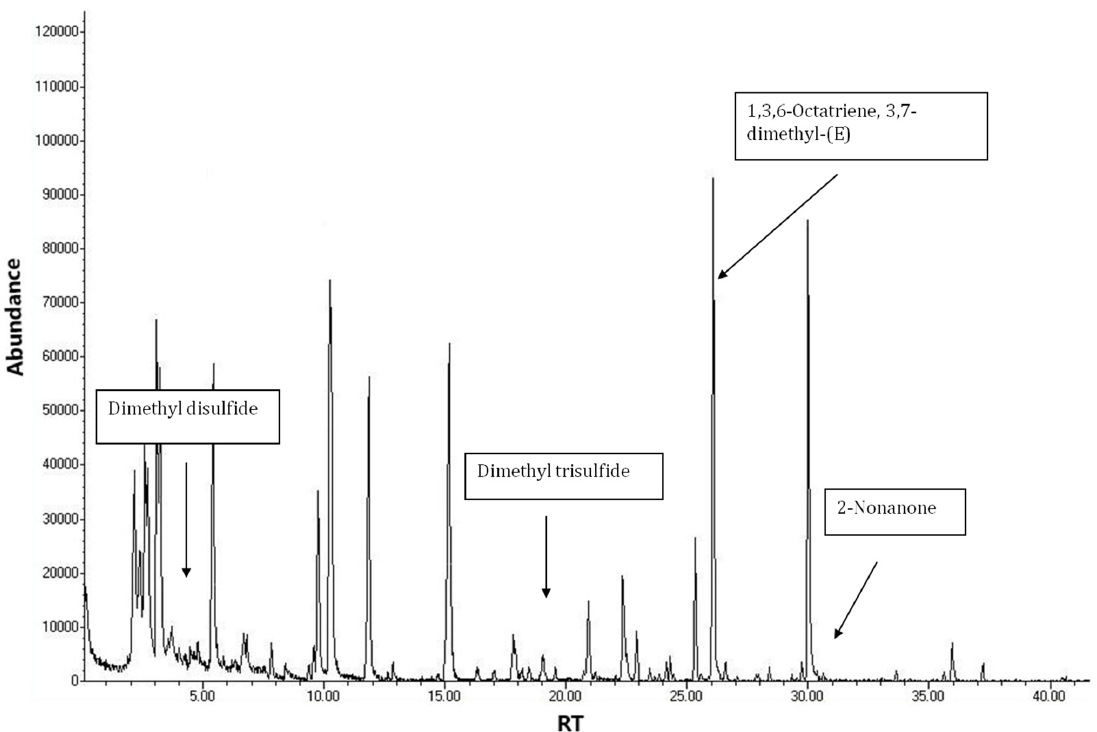
Figure 3. Representative chromatogram of brood infected by AFB (RT: Retention